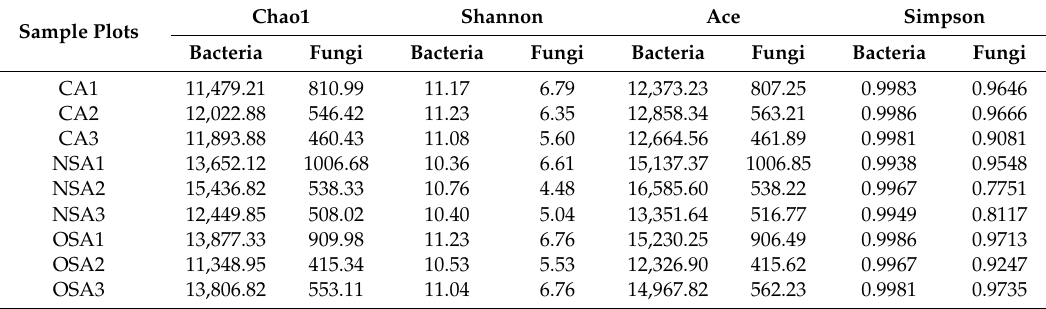
Table 3. Alpha diversity indices of bacteria and fungi in soils at di ff erent depths and di ff erent sample